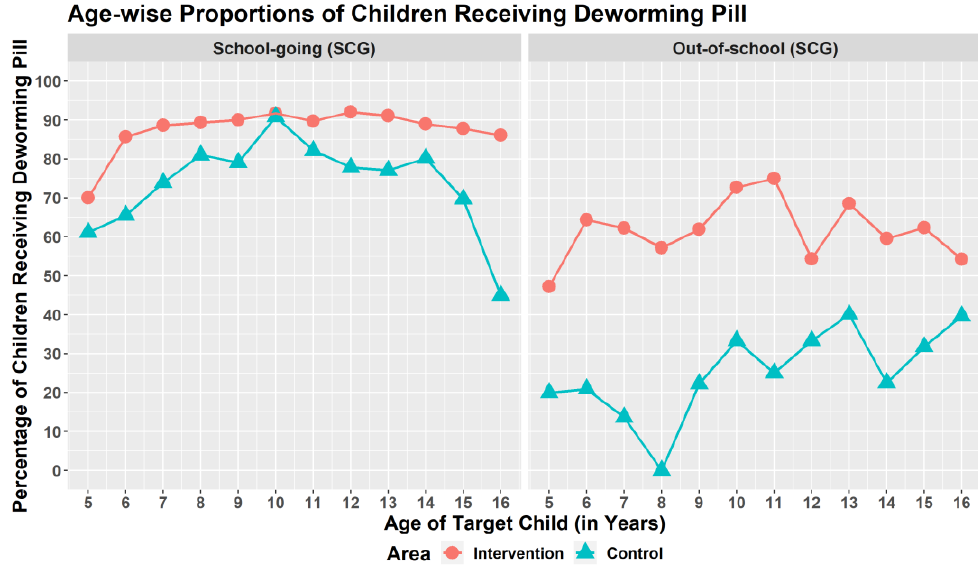
Figure 2. Age-wise proportions of children receiving deworming pill.